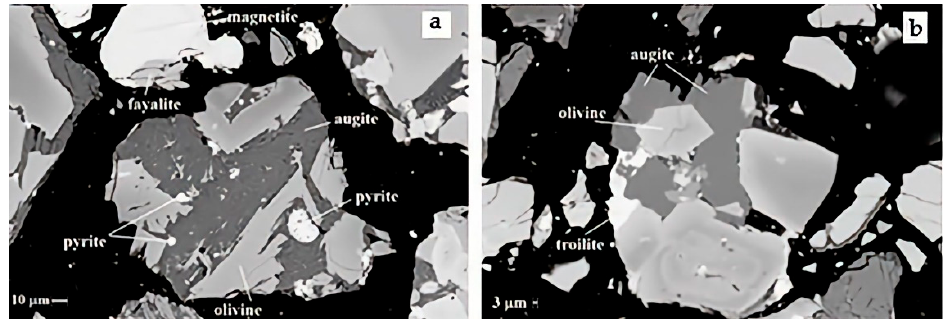
Figure 3. SEM micrograph of slag showing components of the slag: ( a )—sample 807, ( b )—sample 809.